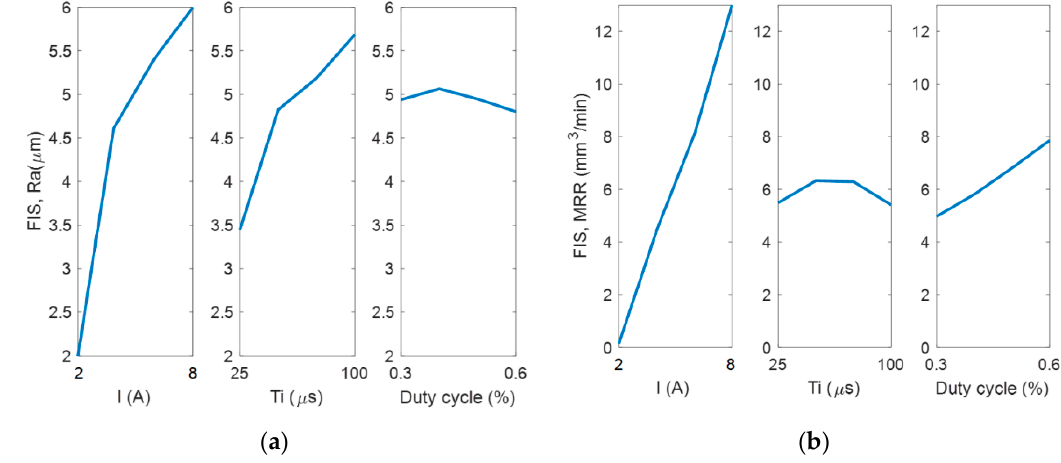
Figure 11. Main effects plot for ( a ) Ra and ( b ) MRR in the case of positive polarity, obtained using the FIS.